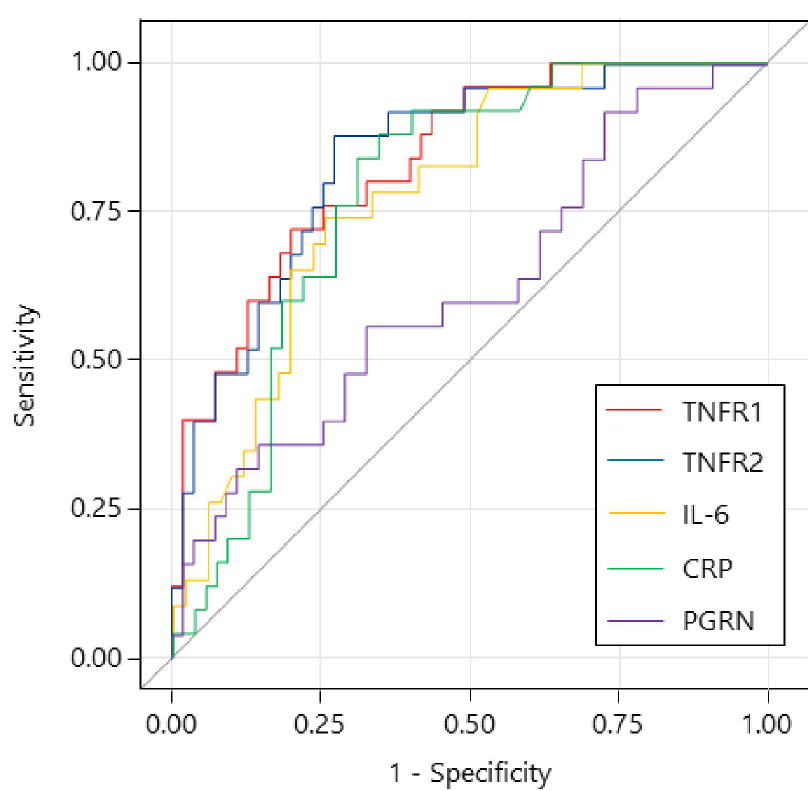
Fig 1. Graph illustrating the diagnostic value of biomarkers for mortality in COVID-19 patients. The diagnostic value of tumor necrosis factor receptor 1 and 2, Interleukin-6, C-reactive protein, and progranulin for mortality. The area under curve values were 0.834, 0.841, 0.778, 0.781, and 0.622, respectively.